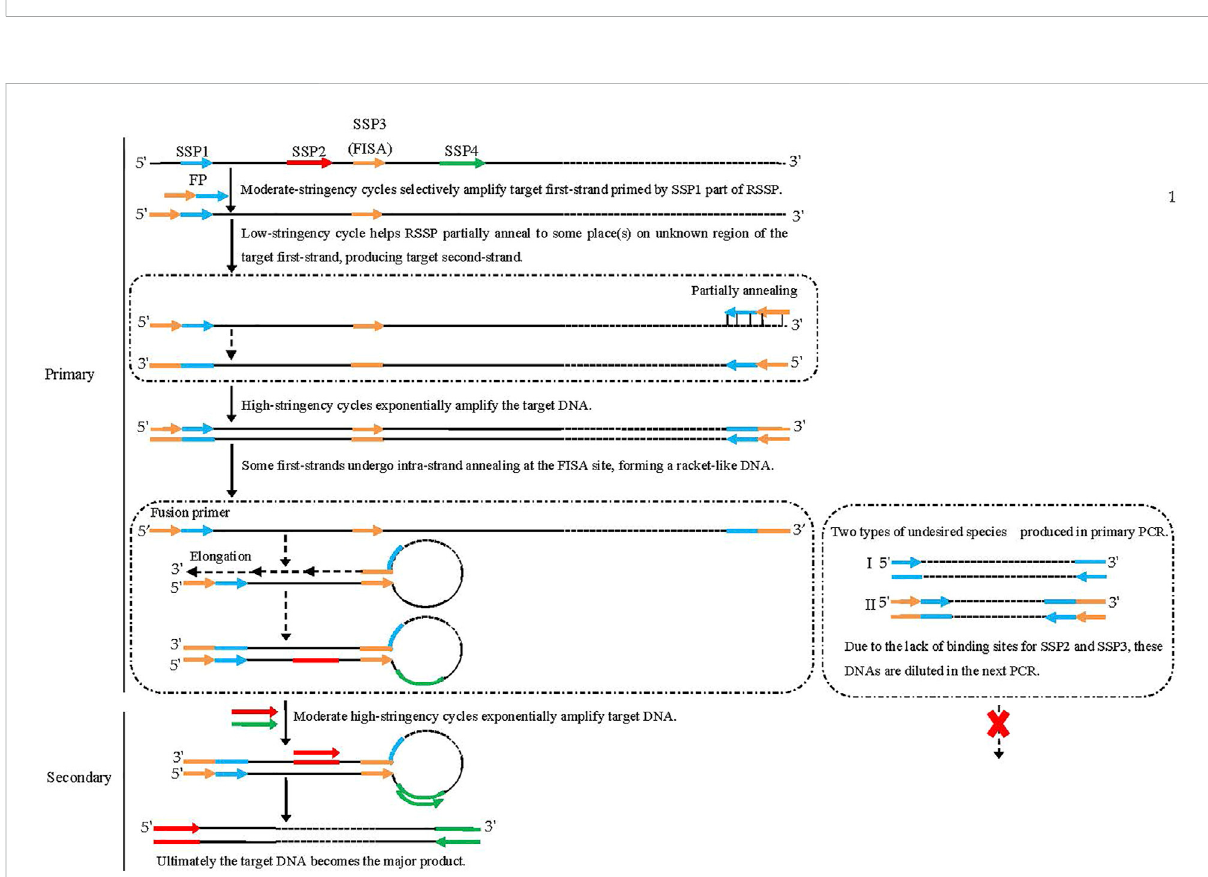
FIGURE 3 Schematicdiagramoffusionprimer-drivenracketPCR.Thefusionprimer3 ′ -partisSSP1,whilethe5 ′ -partistheFISAfragment.Blacksolidlines: known sequences; black dashed lines: unknown sequences; colored solid lines with arrows: primers; colored solid lines: primers